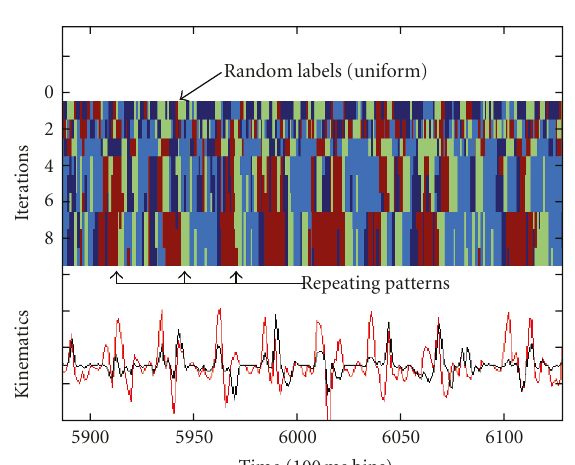
Figure 15: LM-HMM cluster iterations (Ivy 2D dataset, k = 4).